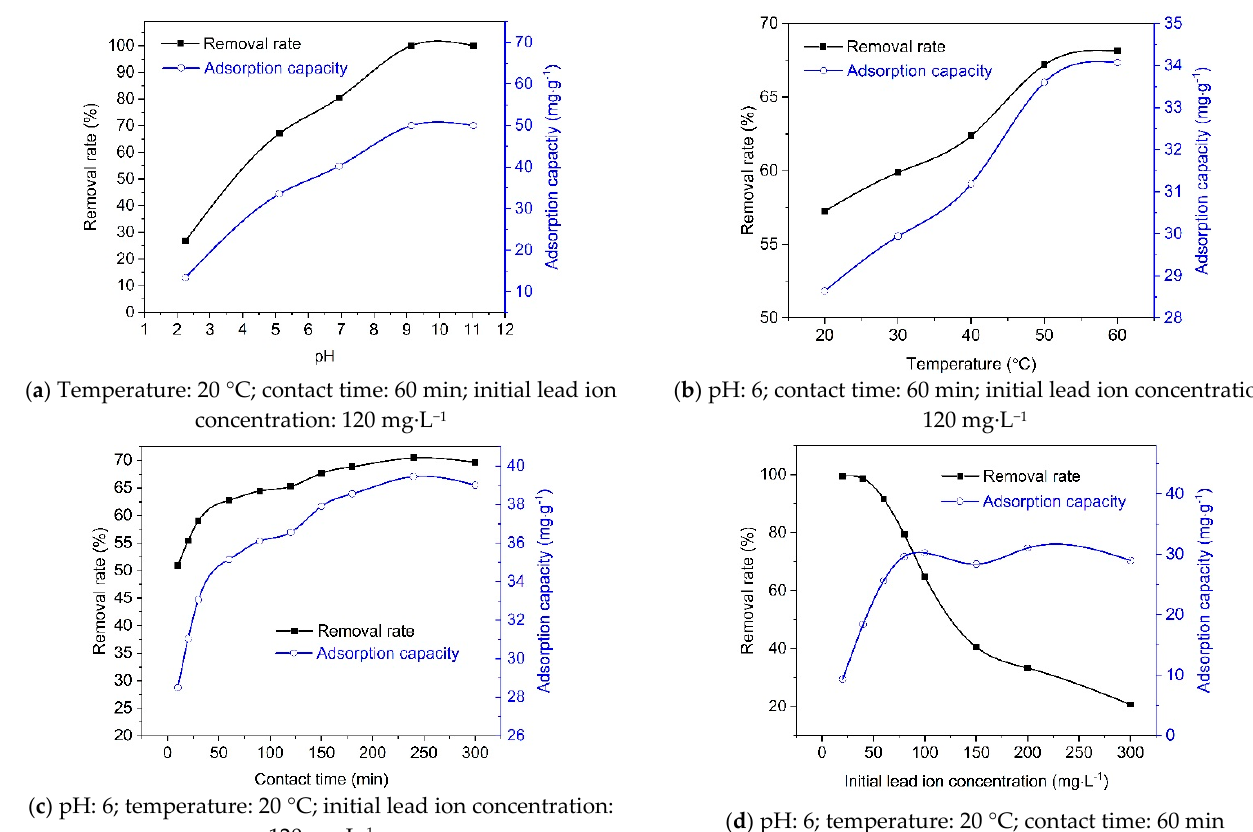
Figure 6. Removal rate and adsorption capacity of lead ions by pristine slag under different pH values ( a ), temperature ( b ), contact time ( c ) and initial concentration ( d ).